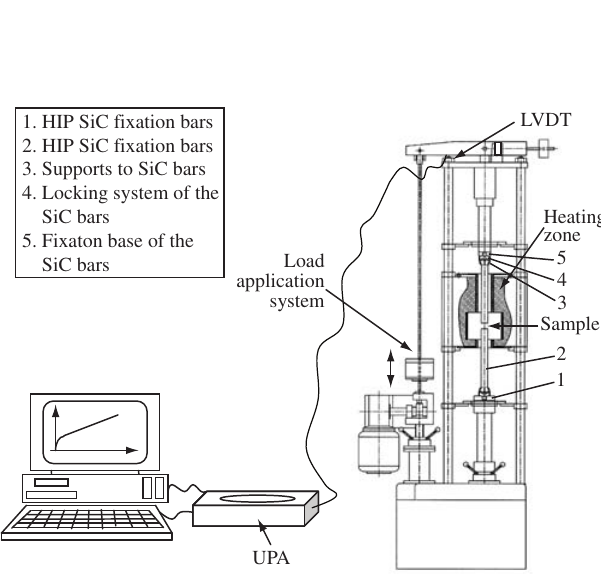
Figure 1. Schematic compressive creep tests apparatus.